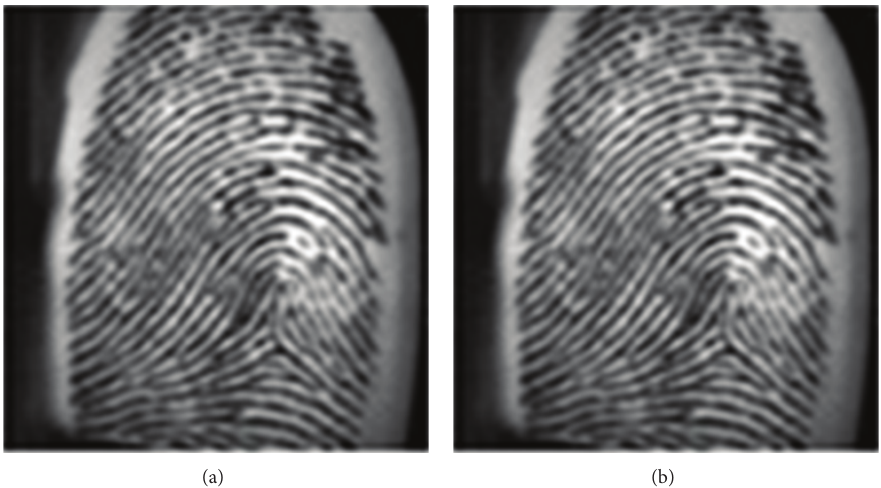
Figure 1: Preprocessing of Fingerprint Image (a) Input Fingerprint Image. (b) Histogram equalized